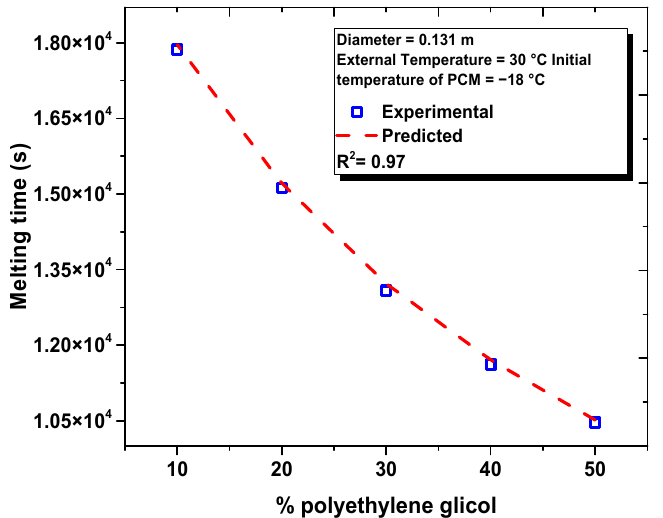
Figure 19. Comparison of the correlation of the melting time with experimental data. Figure 18 confronts the results of the experimental solidification time and the results of the correlation elaborated for the solidification time, and it is noticed that the curves have an excellent agreement with a maximum average deviation of 6% for lower concen- trations of nanofluids. Figure 19 shows the correlation of melting time. A comparison of the predicted time with the experimental melting time shows a difference of about 5% and an average error of 1.8%. These results confirm that the correlations are suitable for predicting the complete solidification and melting times. Finally, the developed correlations will facilitate the cal- culation of the complete solidification and melting times of PCMs of system designs with latent heat storage. 5. Conclusions The present work reports on the results of an experimental and numerical study on the solidification and melting processes of different types of PCM contained in plastic spherical capsules. The simulation results showed that the presence of nanoparticles in the base fluid accelerated the solidification and melting processes and reduced the times